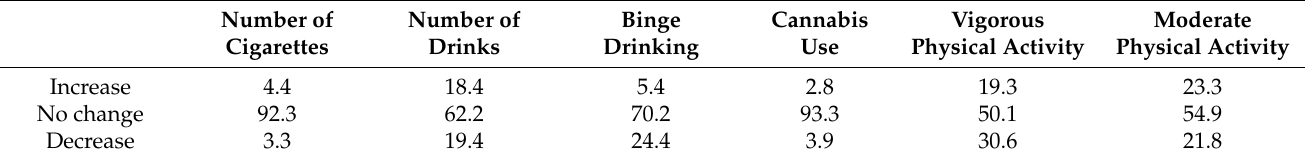
Table 3. Change in HRB before and during the COVID-19 pandemic (in